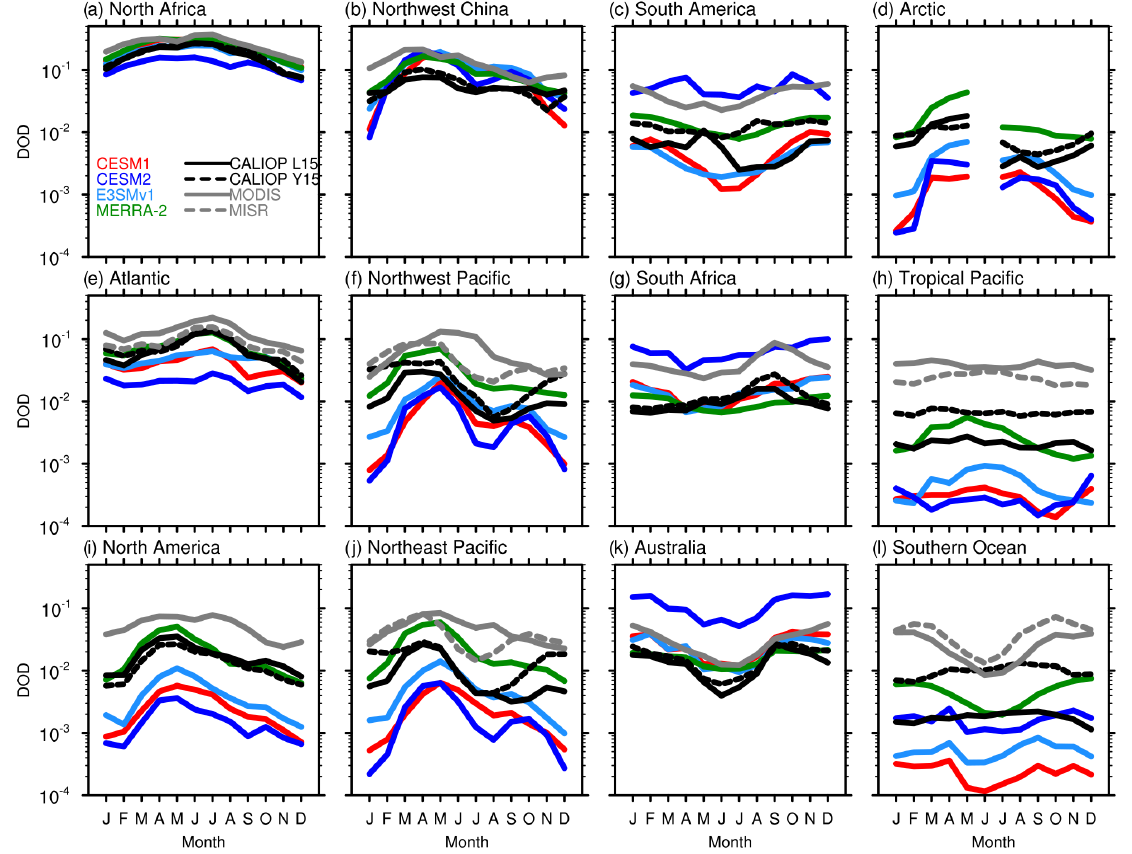
Figure 7. Seasonal variations of DOD from model experiments, CALIOP, MODIS, and MISR over 12 selected regions during 2007–2009. The gap in panel (d) is due to the missing of nighttime data during the polar